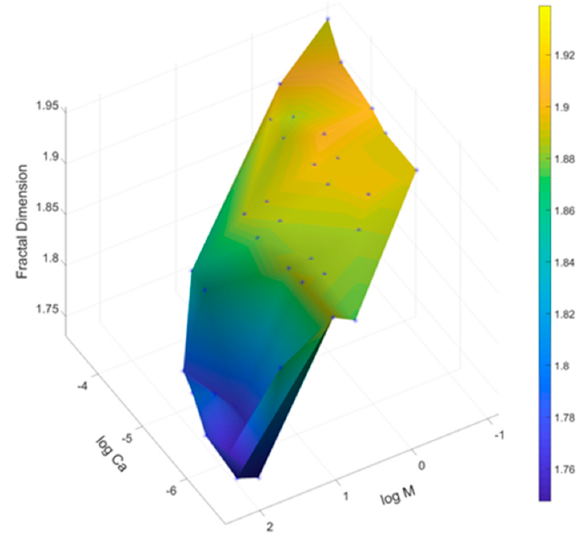
Figure 9. Imbibition fractal dimension with respect to log M and log Ca.